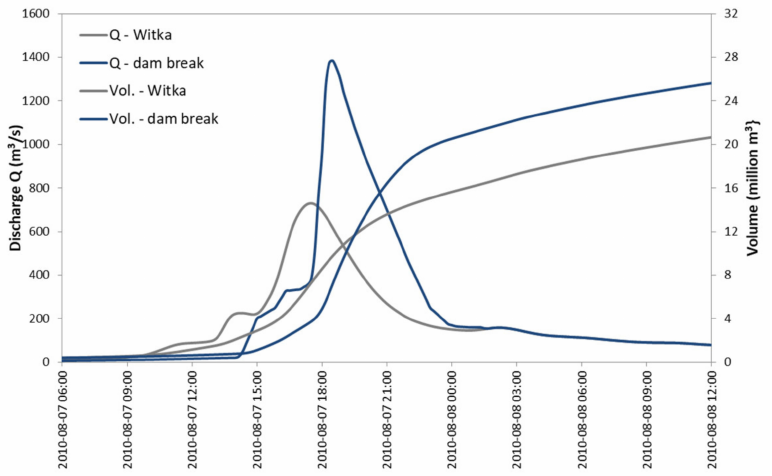
Figure 13. Discharge hydrographs for the inflow to the reservoir and the outflow from the reservoir. The latter was the result of the dam’s failure, which was determined during 2D calculations. The vertical axis on the right shows the cumulated curve of the outflow from the reservoir—the final difference between the curves of both scenarios indicates the water retention in the reservoir under normal